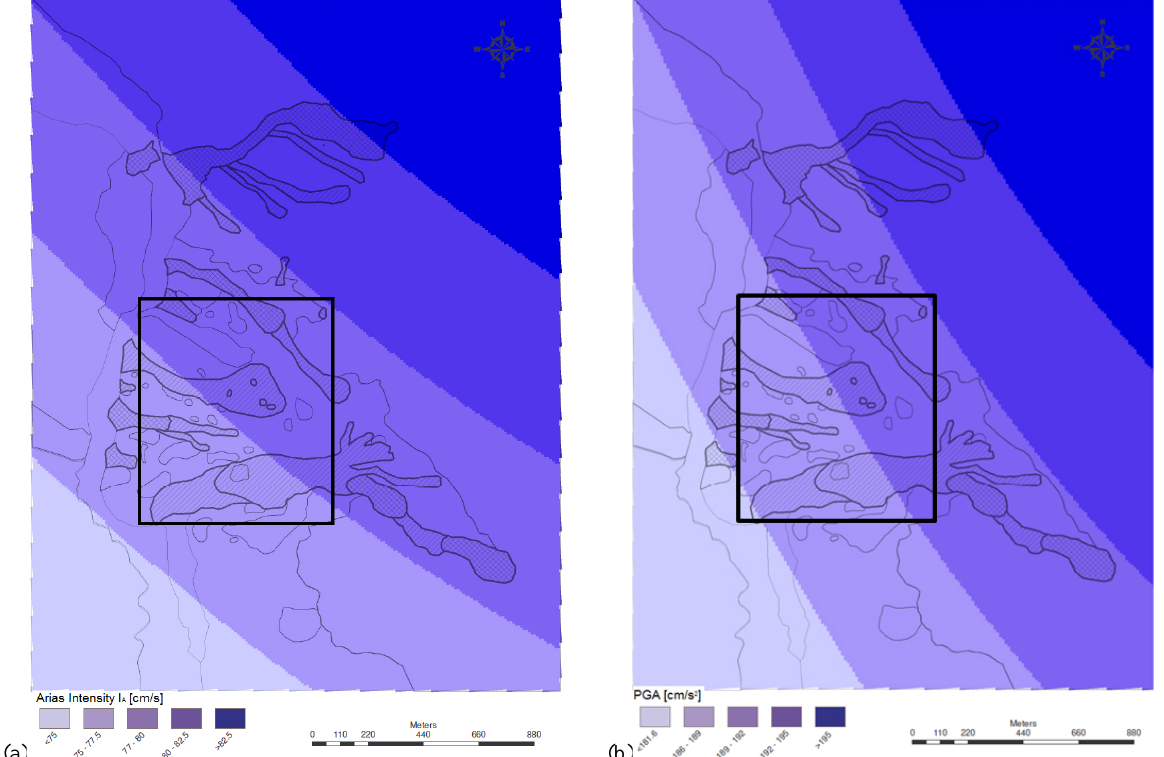
Fig. 5. Interpolated maps of the main features of the 23 November 1980 Irpinia earthquake, derived from the waveforms registered at the twenty seismic stations listed in Table 4: (a) I A and (b) PGA values. The dark rectangle approximately indicates the urban